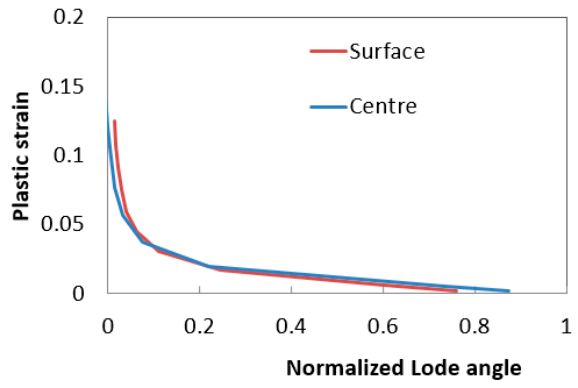
Figure 29. Lode angle for plane strain test.